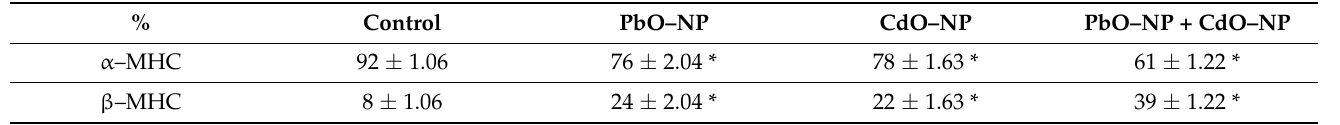
Figure 2. Representative examples of electrophoregrams showing the location of α – and β –myosin heavy chains (MHC) recovered from the myocardium of rats. Left to right: control, group after exposure to PbO–NP, after exposure to CdO–NP, after combined exposure to PbO–NP and CdO–NP, and after combined exposure against oral bioprophylactic complex (BPC) administration. Table 2. Percentage of α – and β –myosin heavy chains in myocardium. ( X(cid:3365) ± s.e.).